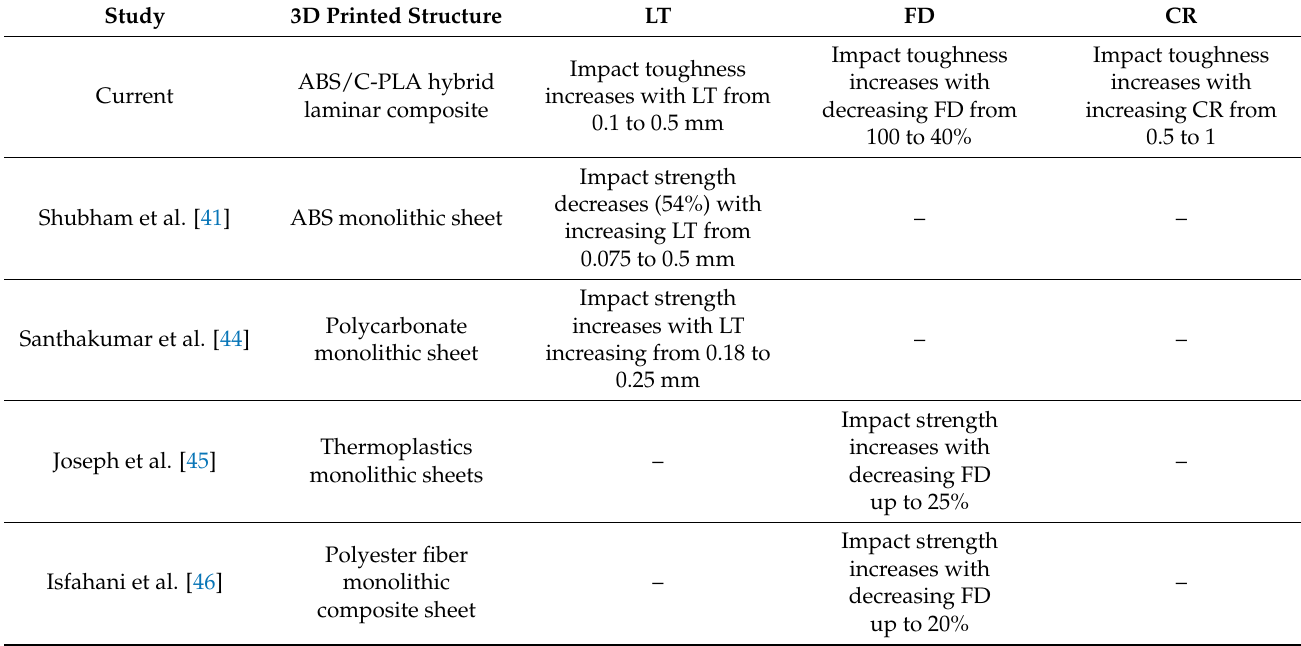
Table 6. Comparison between the present and past